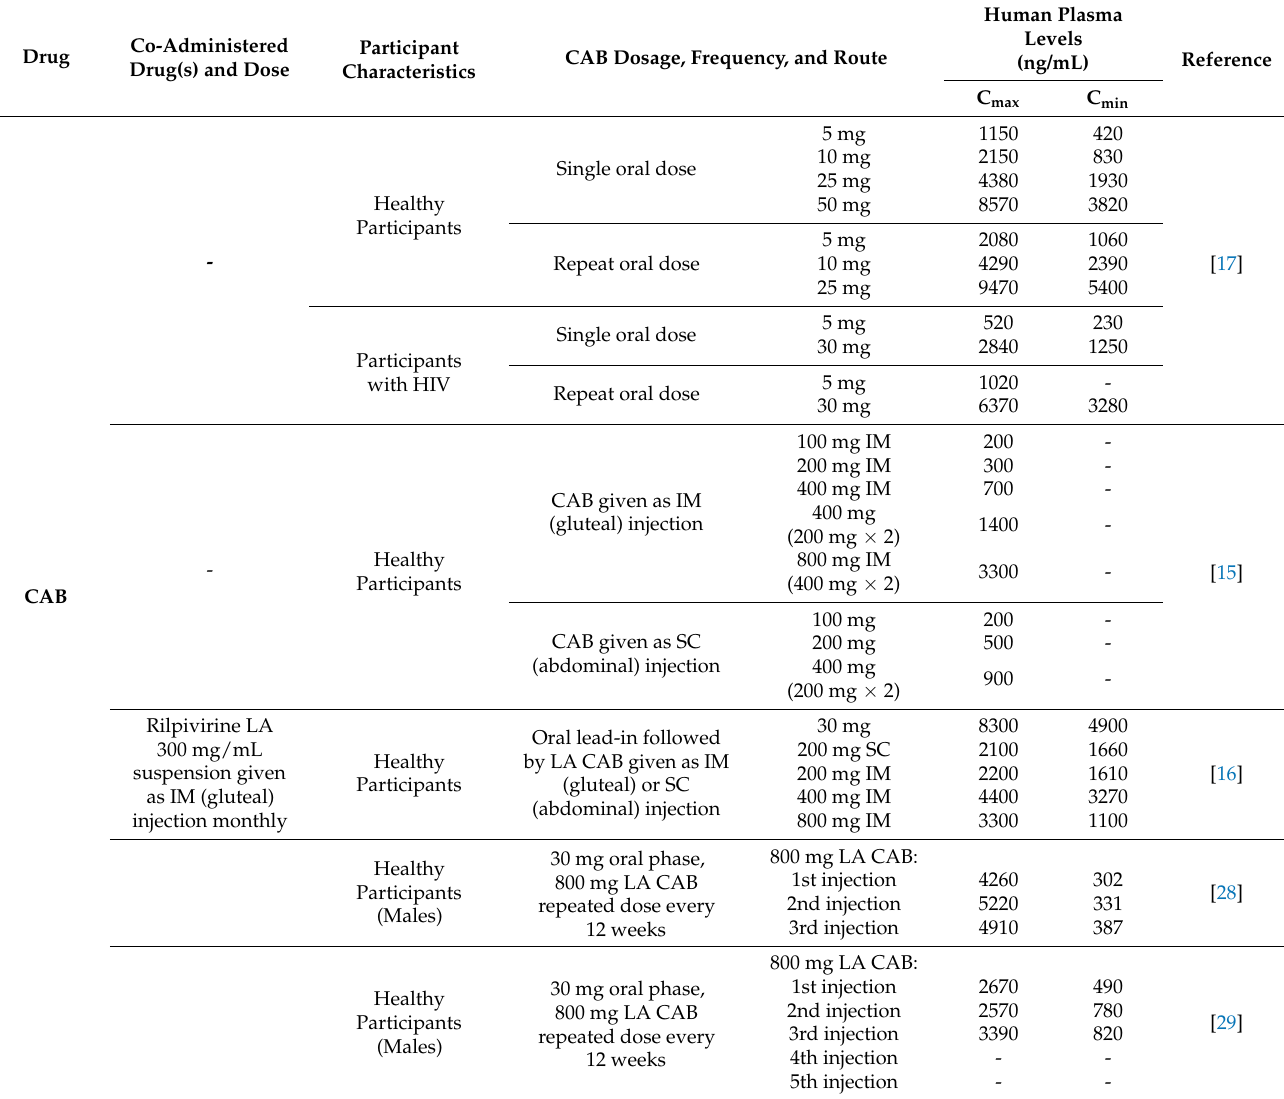
Table 2. Literature review of HIV CAB pharmacokinetic studies in